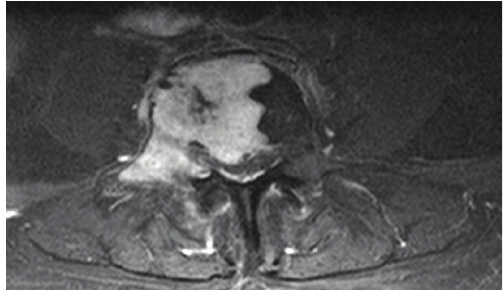
Figure 1: MRI lumbar spine: enhanced T1 weighted axial image. Enhancing, well-defined benign phosphaturic mesenchymal tumor in lumbar vertebra.